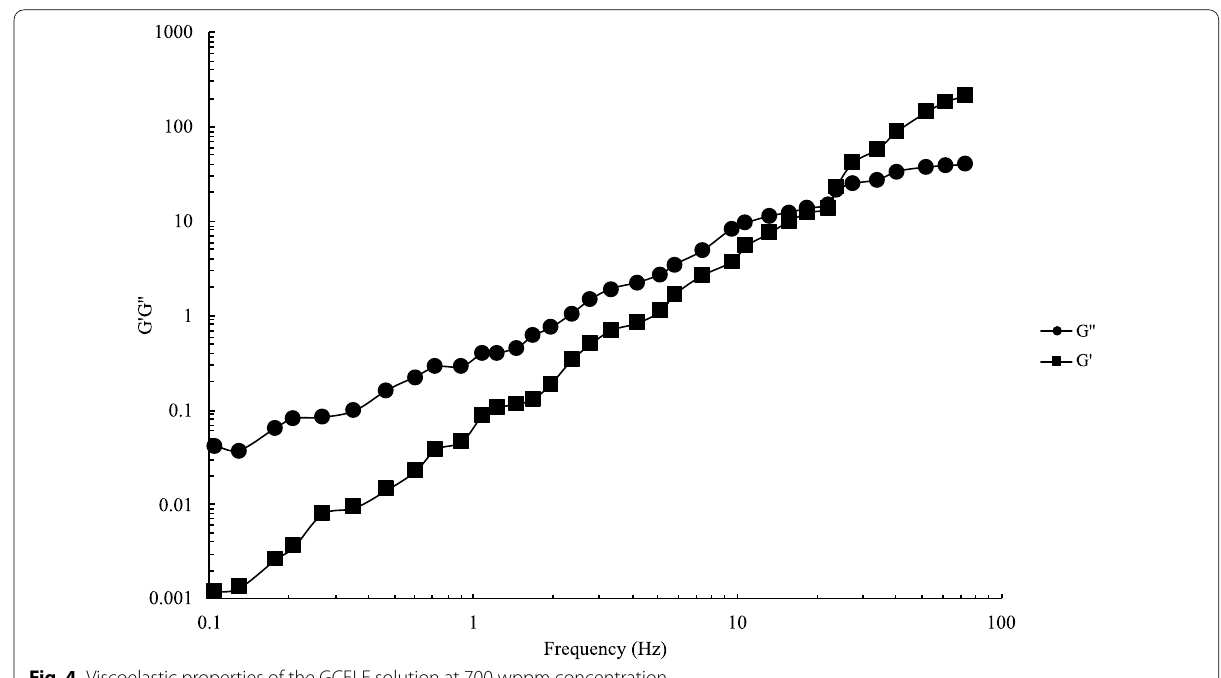
Fig. 4 Viscoelastic properties of the GCELE solution at 700 wppm concentration